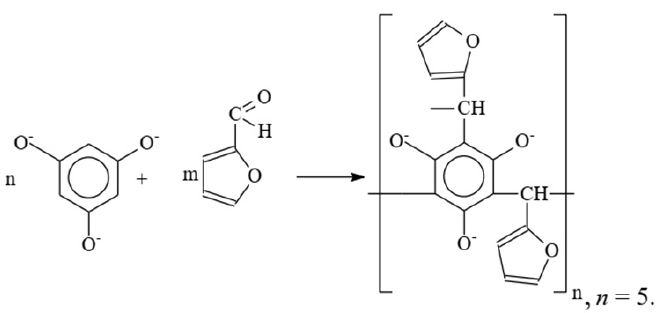
Figure 11. Scheme of the joint condensation of 1,3,5-trioxybenzene with 2-furaldehyde in an alka- line medium. line